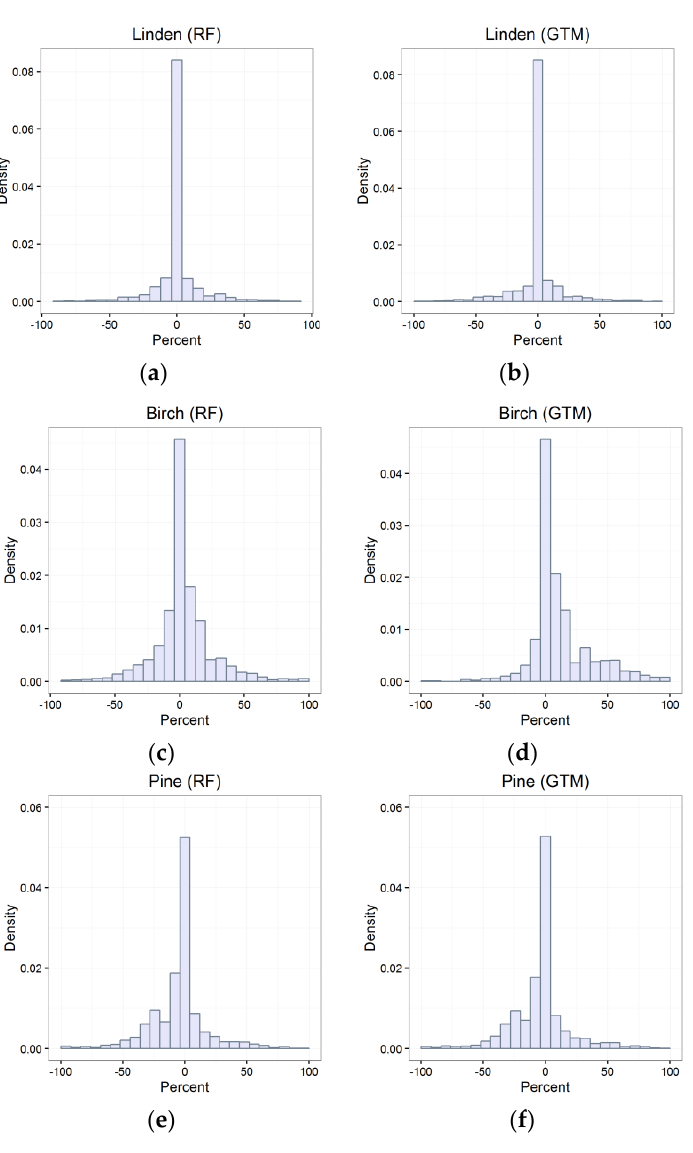
Figure 7. Frequencies histograms of the difference between real and model percentages of species in